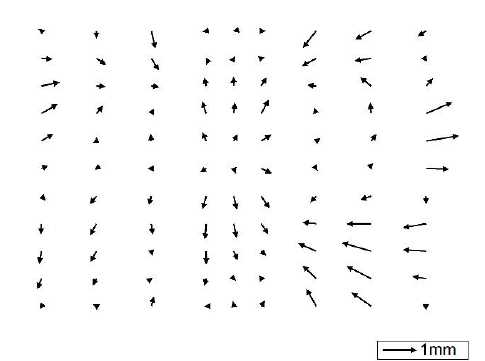
Figure 7. Result of camera calibration of center image